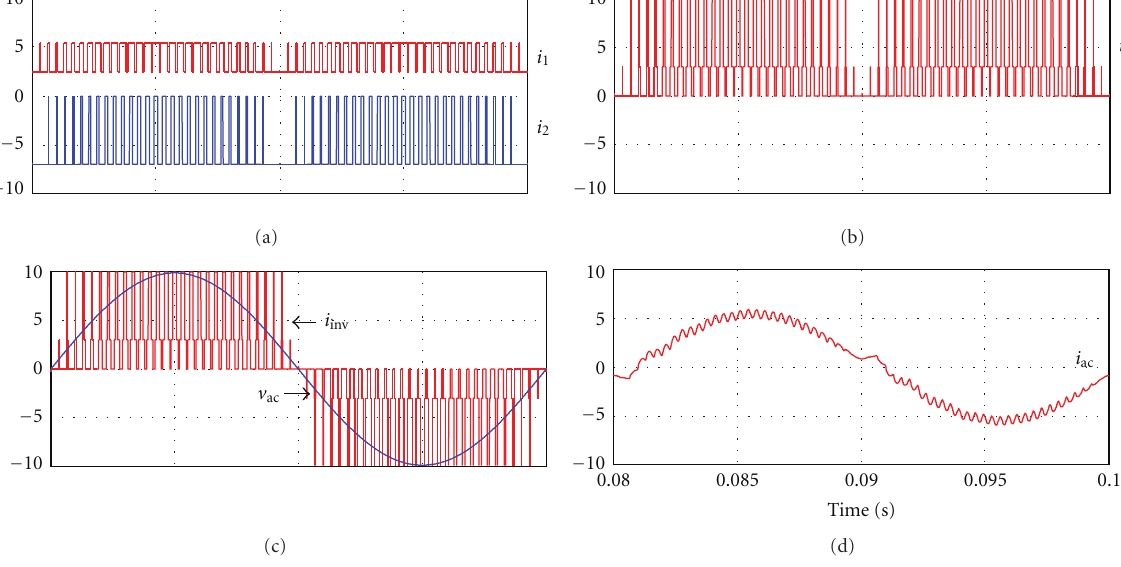
Figure 15: Operation of the system under the conditions of m pv > m wind , I pv < I wind , f line = 50Hz and f sw = 3 kHz (top to bottom) i 1 , i 2 , i dc , v i i inv , ac , and ac